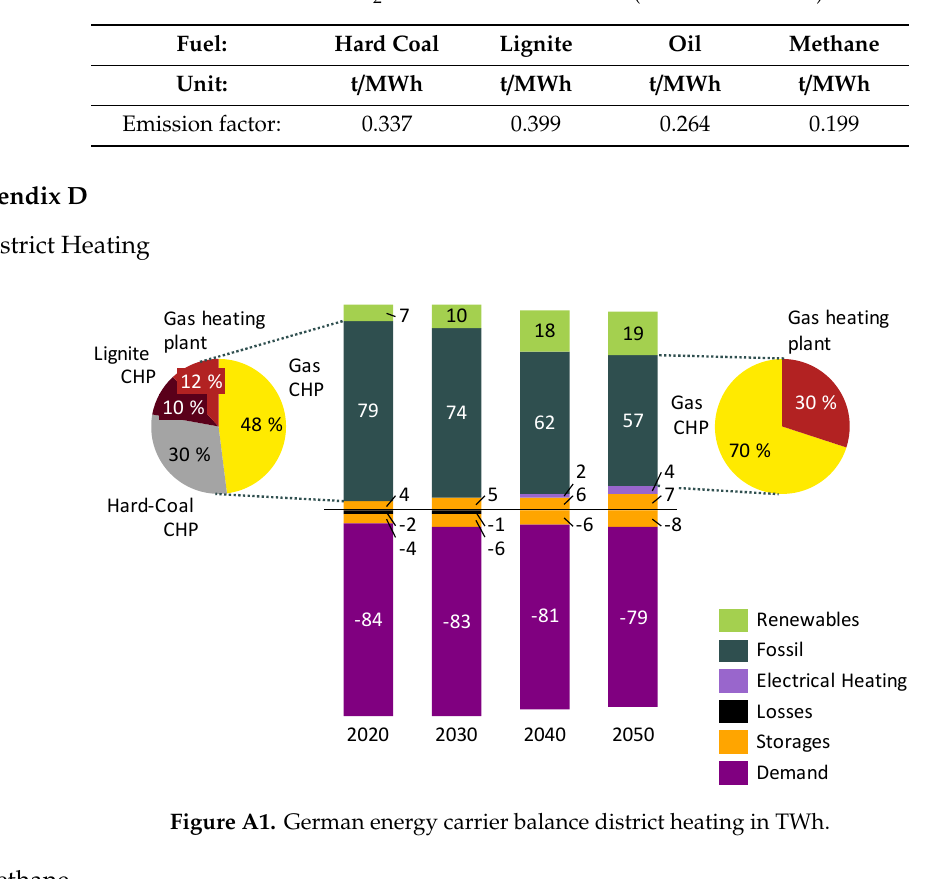
Table A2. Direct CO 2 emission factors of fuels (net calorific value).